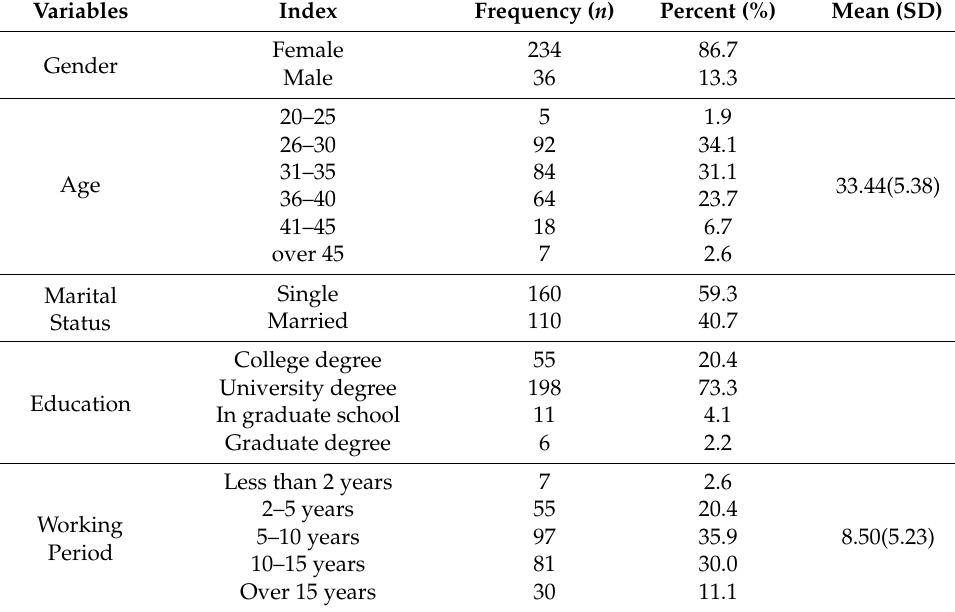
Table 1. Characteristics of the